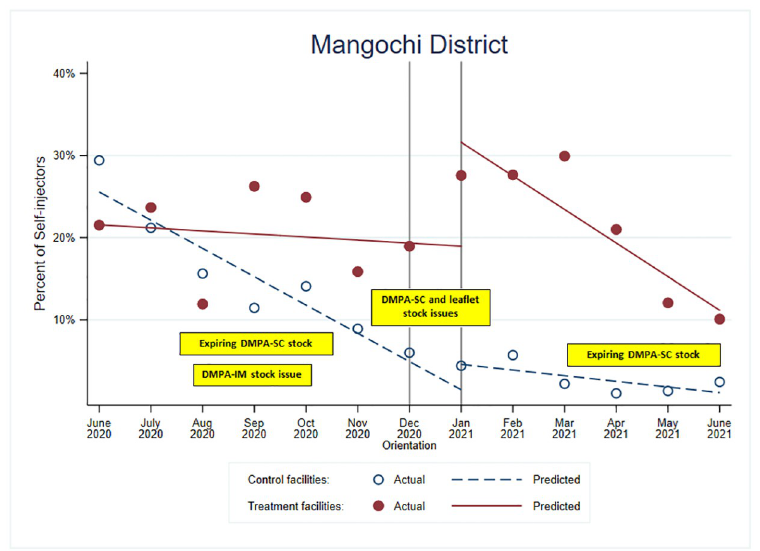
Fig 4. Percentage of total injections that were DMPA-SC self-injected and model-based trends for treatment and control facilities in Mangochi District,